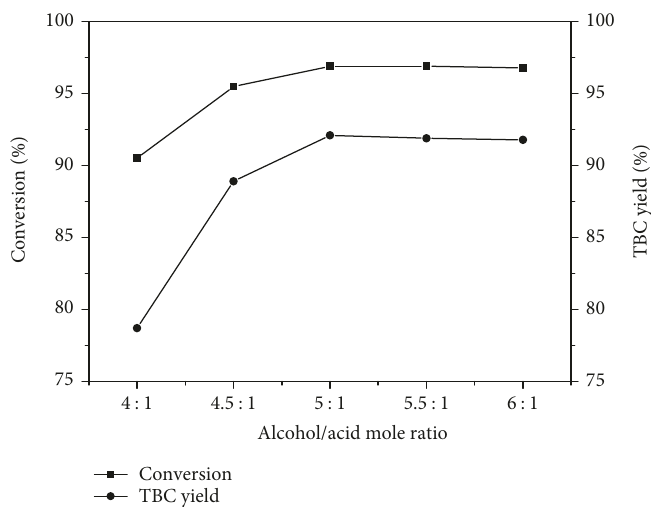
Figure 1: E ff ect of the n-butanol to citric acid molar ratio on the esteri fi cation of citric acid with n-butanol. Reaction conditions: citric acid, 0.06mol; n-butanol, 0.3mol; catalyst, 6 wt%; temperature, 115 ° C; time, 5 h.